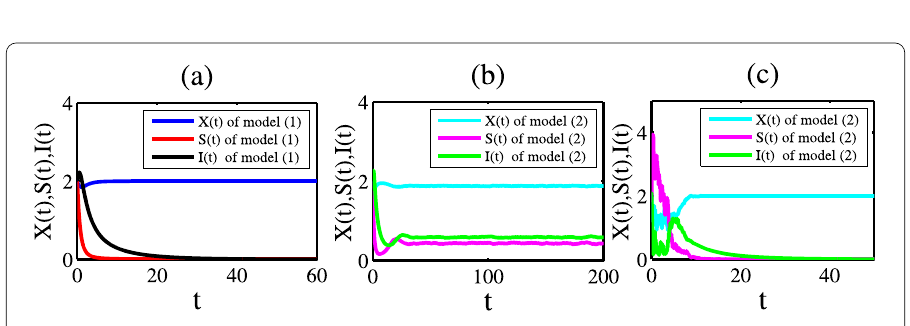
Figure 5 Persistence in mean and extinction of model (2). (a) The deterministic model; (b) persistence in mean of model (2); (c) extinction of model